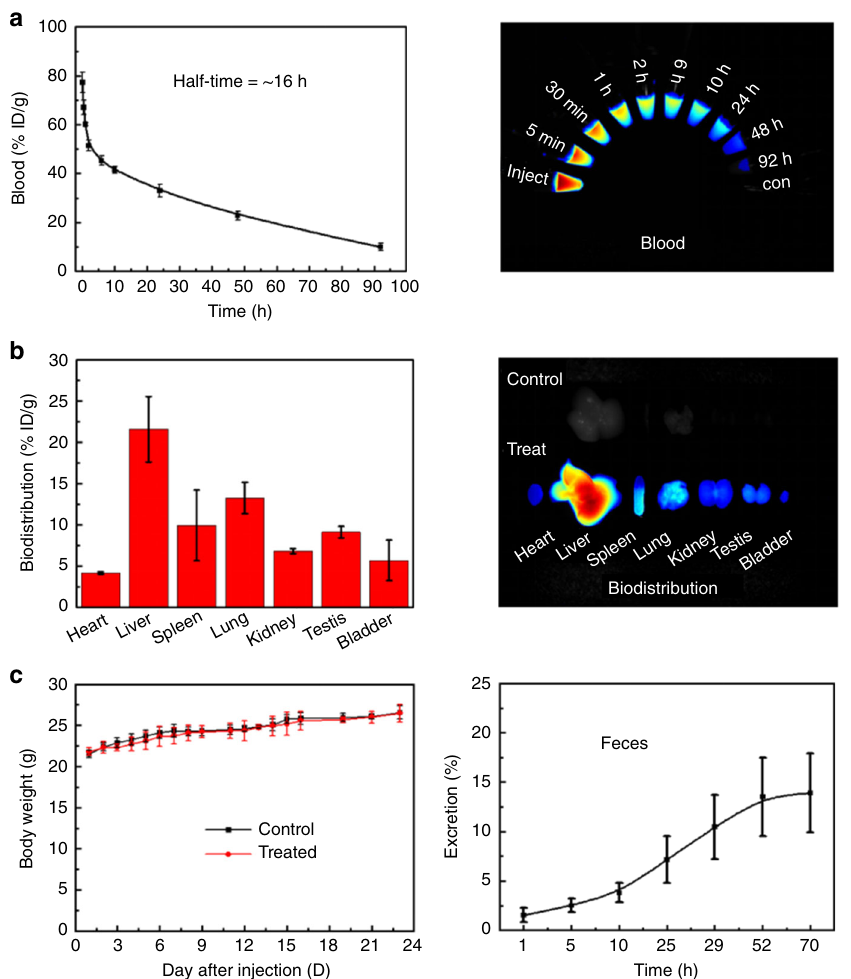
Fig. 5 Evaluation of pharmacokinetics and biocompatibility of p-FE ( n = 3 mice/group). a Time course of blood concentration in 92 h. Fluorescence signal decreased from 77.31 to 9.91%, with a long blood circulation half-life time of ~16 h and corresponding fl uorescence images of blood samples. b Biodistribution of main organs of p-FE-treated mice after 24 h post injection. c Body weight of p-FE-treated mice ( n = 6 mice/ group) over a period of time of 23 days and the excretion behavior of p-FE. Error bars correspond to standard